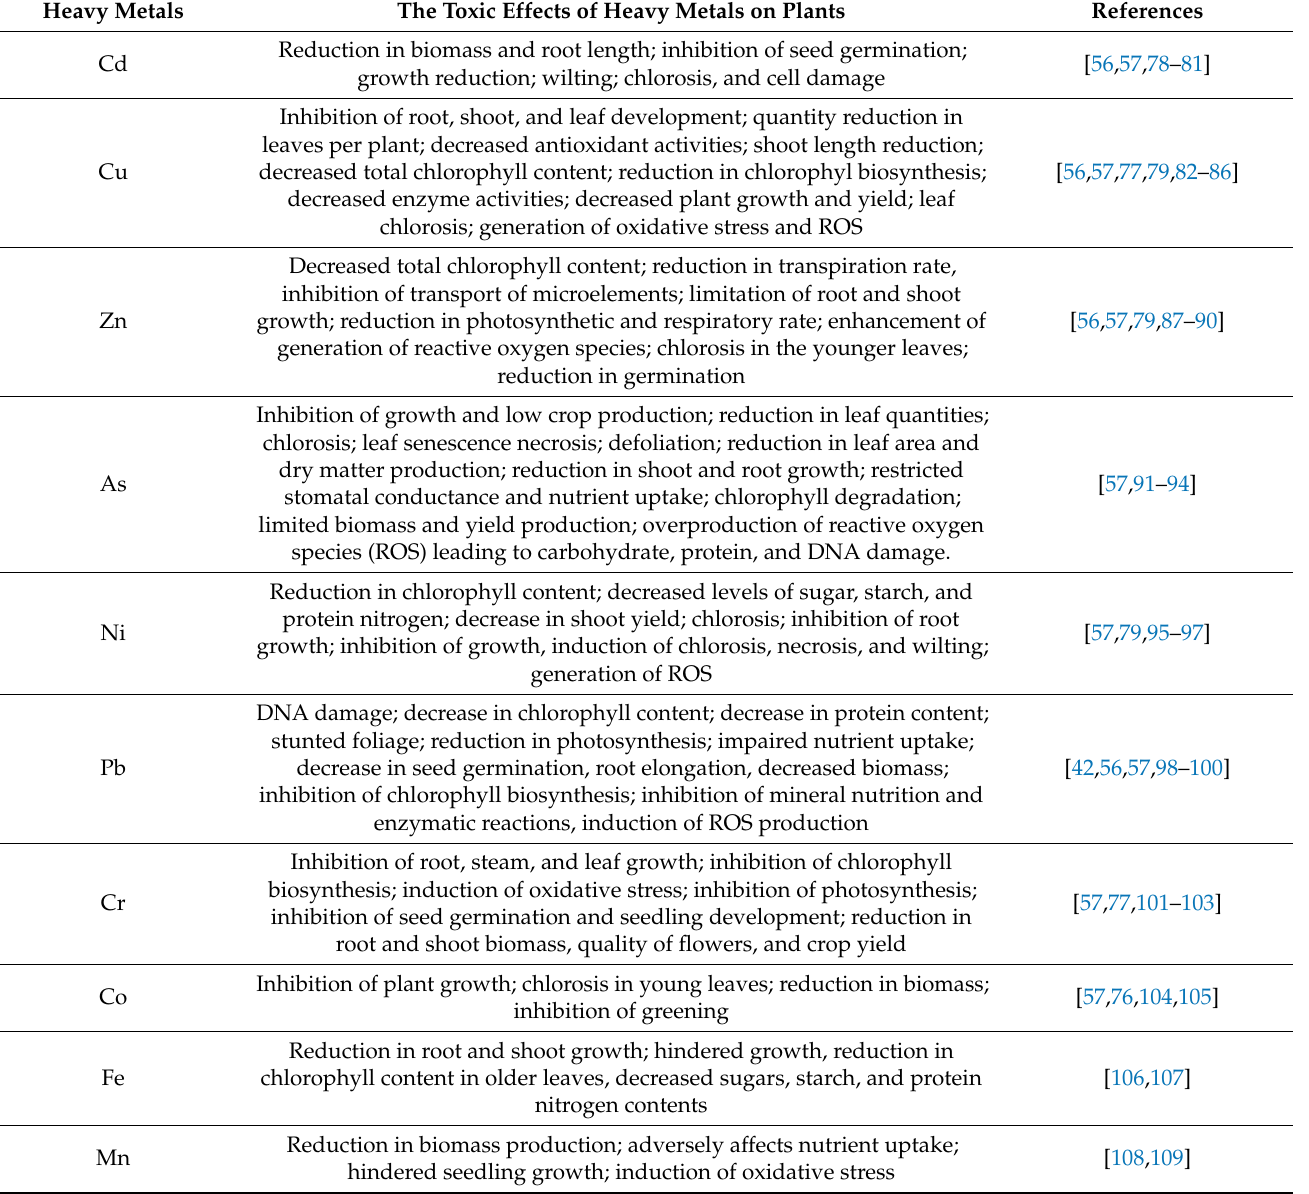
Table 1. The toxic effects of excess heavy metals on